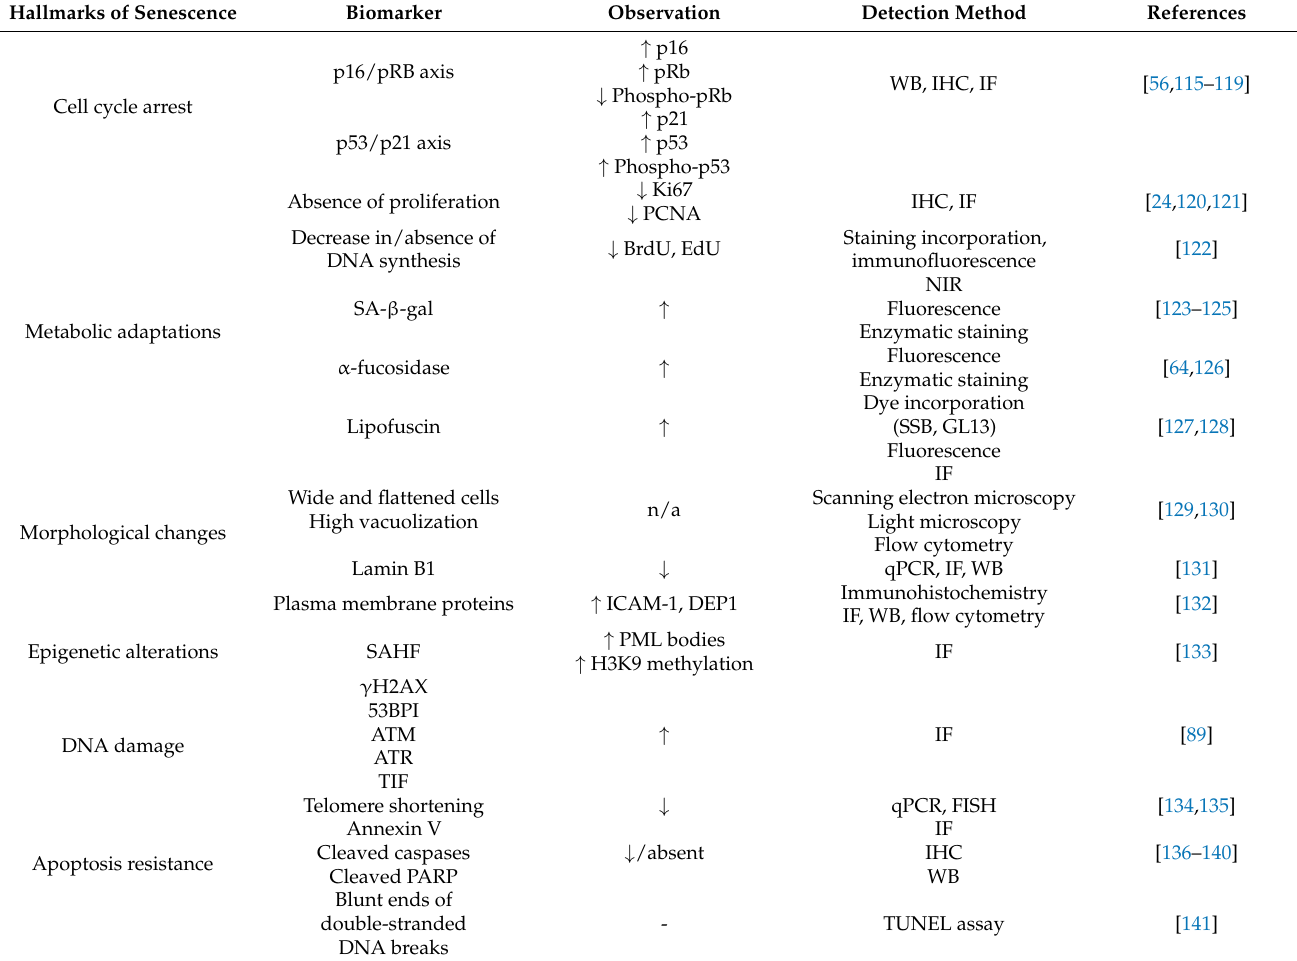
Table 2. Biomarkers of cellular senescence and general detection methods used to identify